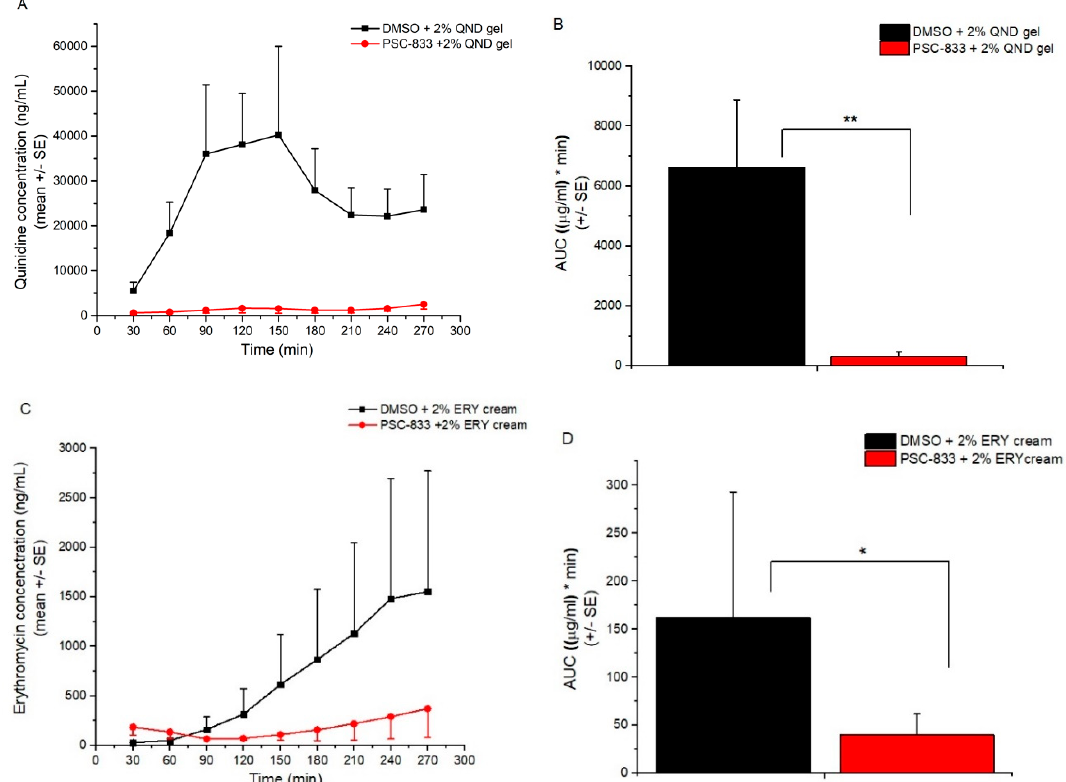
Figure 7. Skin penetration of quinidine gel (QND) (Panel A , B ) and erythromycin cream (ERY)